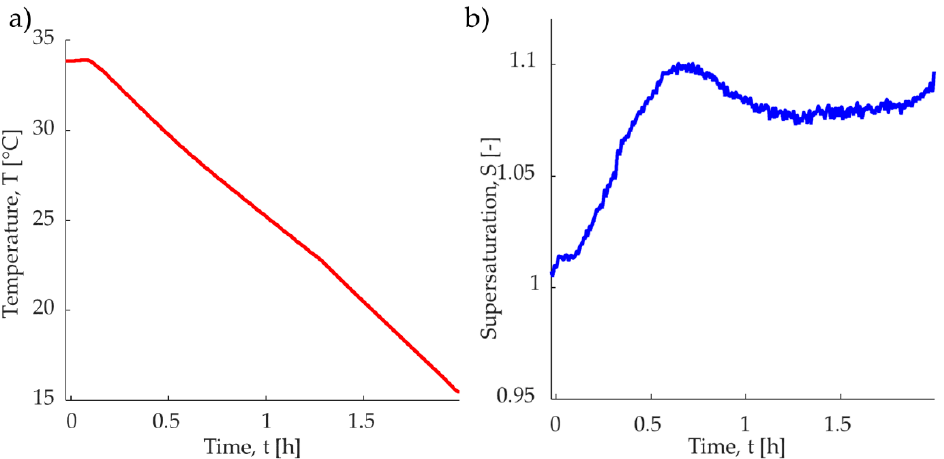
Figure A7. ( a ) Percentiles and mean values of the crystal size distributions for Exp. 2 - KH 2 PO 4 t hin lines - percentiles of the q 0- distribution; bold lines – percentiles of the q 3 -distributions; Solid lines - percentiles and mean values shadowgraphic probe; Dashed lines - percentiles and mean values QICPIC; brown; magenta − 0.15 and 0.85 percentile of the corresponding distribution; blue - mean size of the corresponding distribution. ( b ) Comparison of the mass distribution: shadowgraphic probe, QICPIC, sieve analysis.